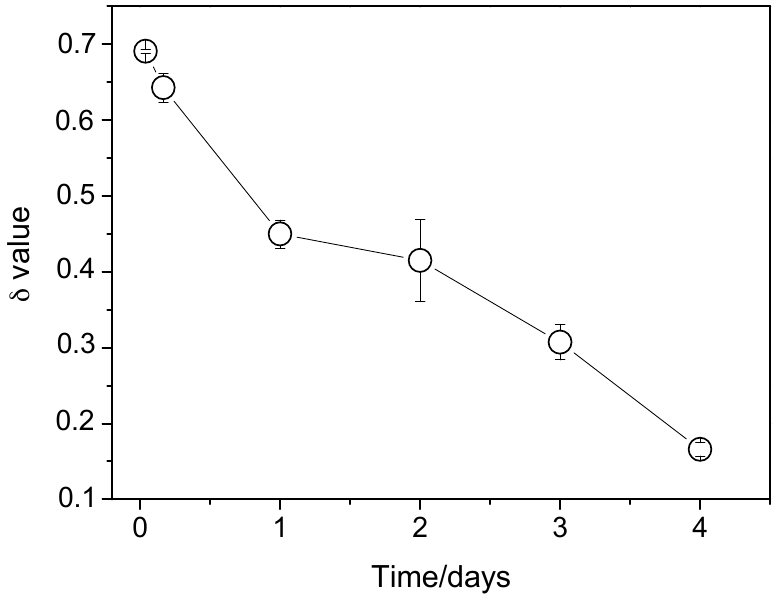
Figure 9. Evolution of the δ values with immersion time of AZ31B in Ringer’s solution (37 ◦ C). Scatter bands are the standard deviation of 3 measurements. To illustrate the relationship between the localized pitting corrosion of AZ31B and the inductive behavior, Figure 10 presents a comparison between the EIS spectra after two (Figure 10a) and four (Figure 10b) days of immersion in the Ringer’s solution (37 ◦ C) and the optical cross-sectional images of the tested samples (Figure 10c,d). It can be observed that the inductive loop size is independent of the severity of the pitting corrosion